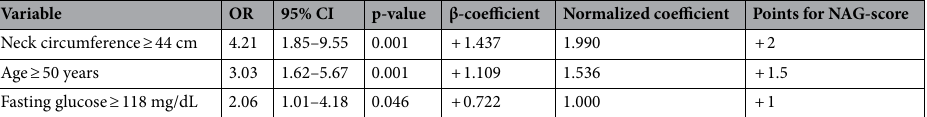
Table 2. Prediction of BS failure, defined as %EWL < 50% at 2 years, by multivariate logistic regression after stepwise backward selection of pre-surgical data; NAG-score point assignment according to multivariate